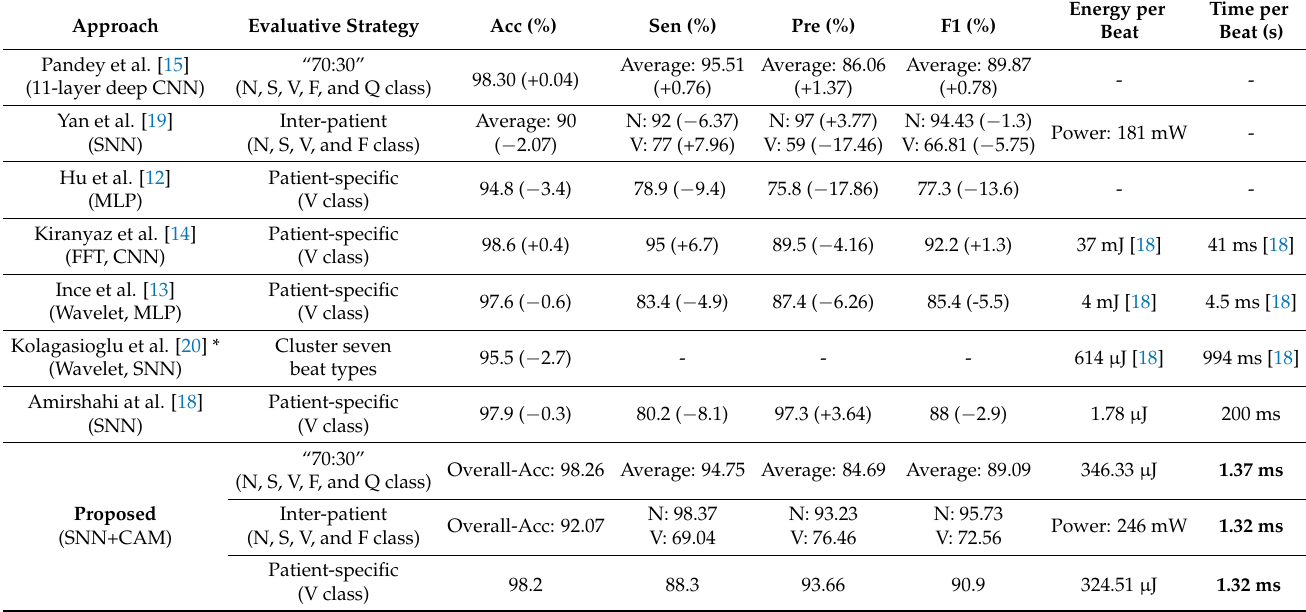
Table 6. Performance comparison of our proposed approach with other previous work. The values in parentheses denote comparisons with our approach. And the work marked with an asterisk classified seven types of